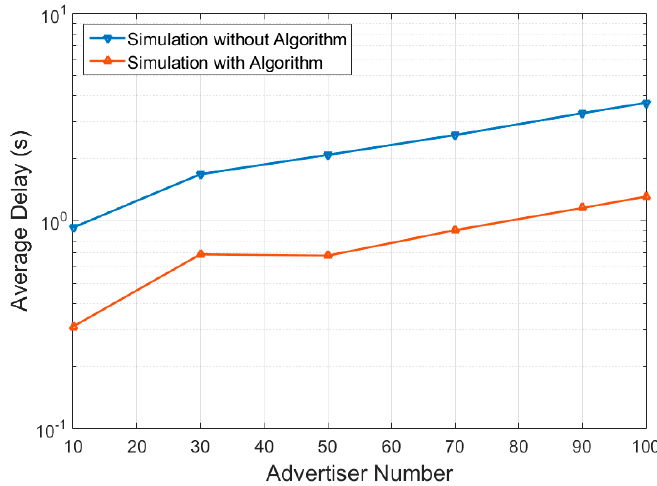
Figure 7. Average delay for advertiser discovery by the scanner.